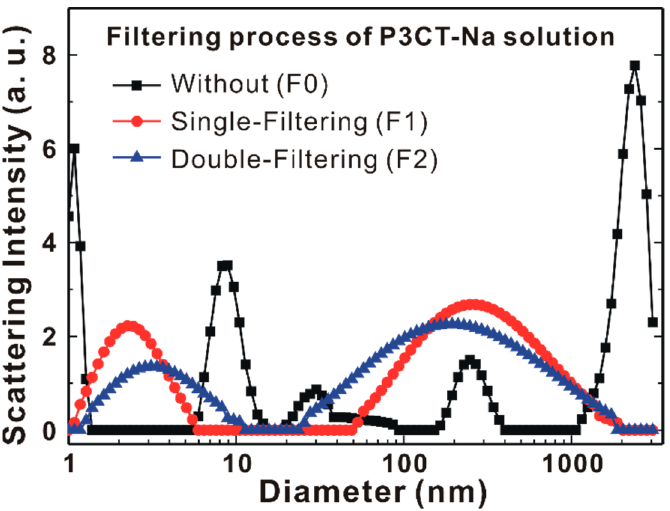
Figure 3. Particle sizes of aggregated P3CT-Na polymers in water solutions without and without the filtering processes.